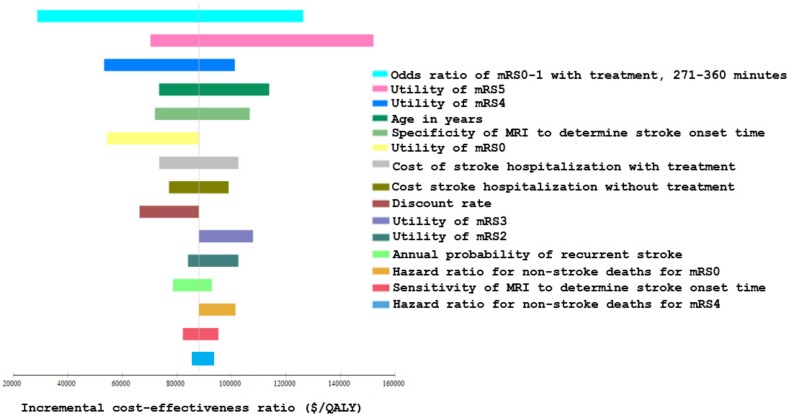
One-way sensitivity analysis results (ICERs for MRI-based strategy vs. no treatment).Tornado diagram summarizing one-way sensitivity analyses for the MRI-based strategy compared to the no treatment strategy for the base-case analysis. Most incremental cost-effectiveness ratios (ICERs) were close to the base-case result ($88,000/QALY) as model parameters were varied through plausible ranges, with the exceptions of the odds ratio of mRS0-1 with treatment for patients with stroke onset time 271–360 minutes, utility values for mRS5 and mRS4 health states, age in years, and MRI specificity. Parameters are shown in descending order of influence on model results.